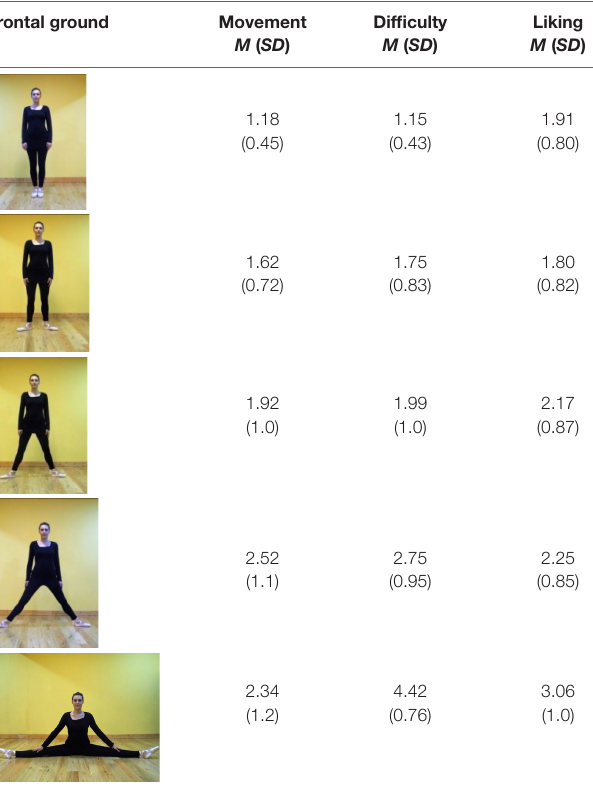
TABLE 3 | Frontal on-ground poses: mean ratings (and SD) for movement, difficulty, and